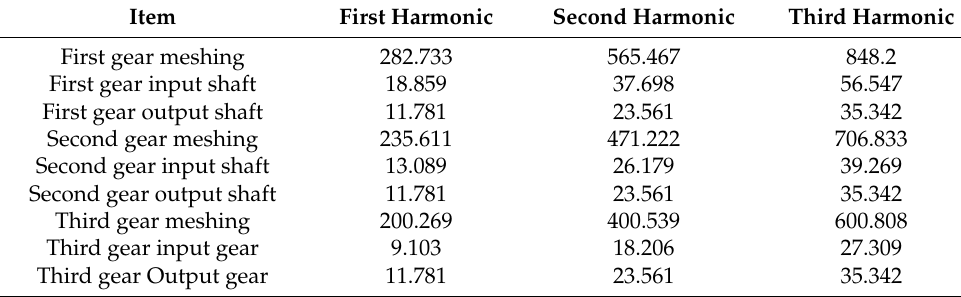
Table 2. Main order of differential steering gearbox in each